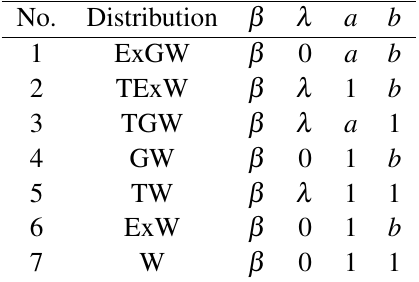
Table 1. Sub-models of the TExGW